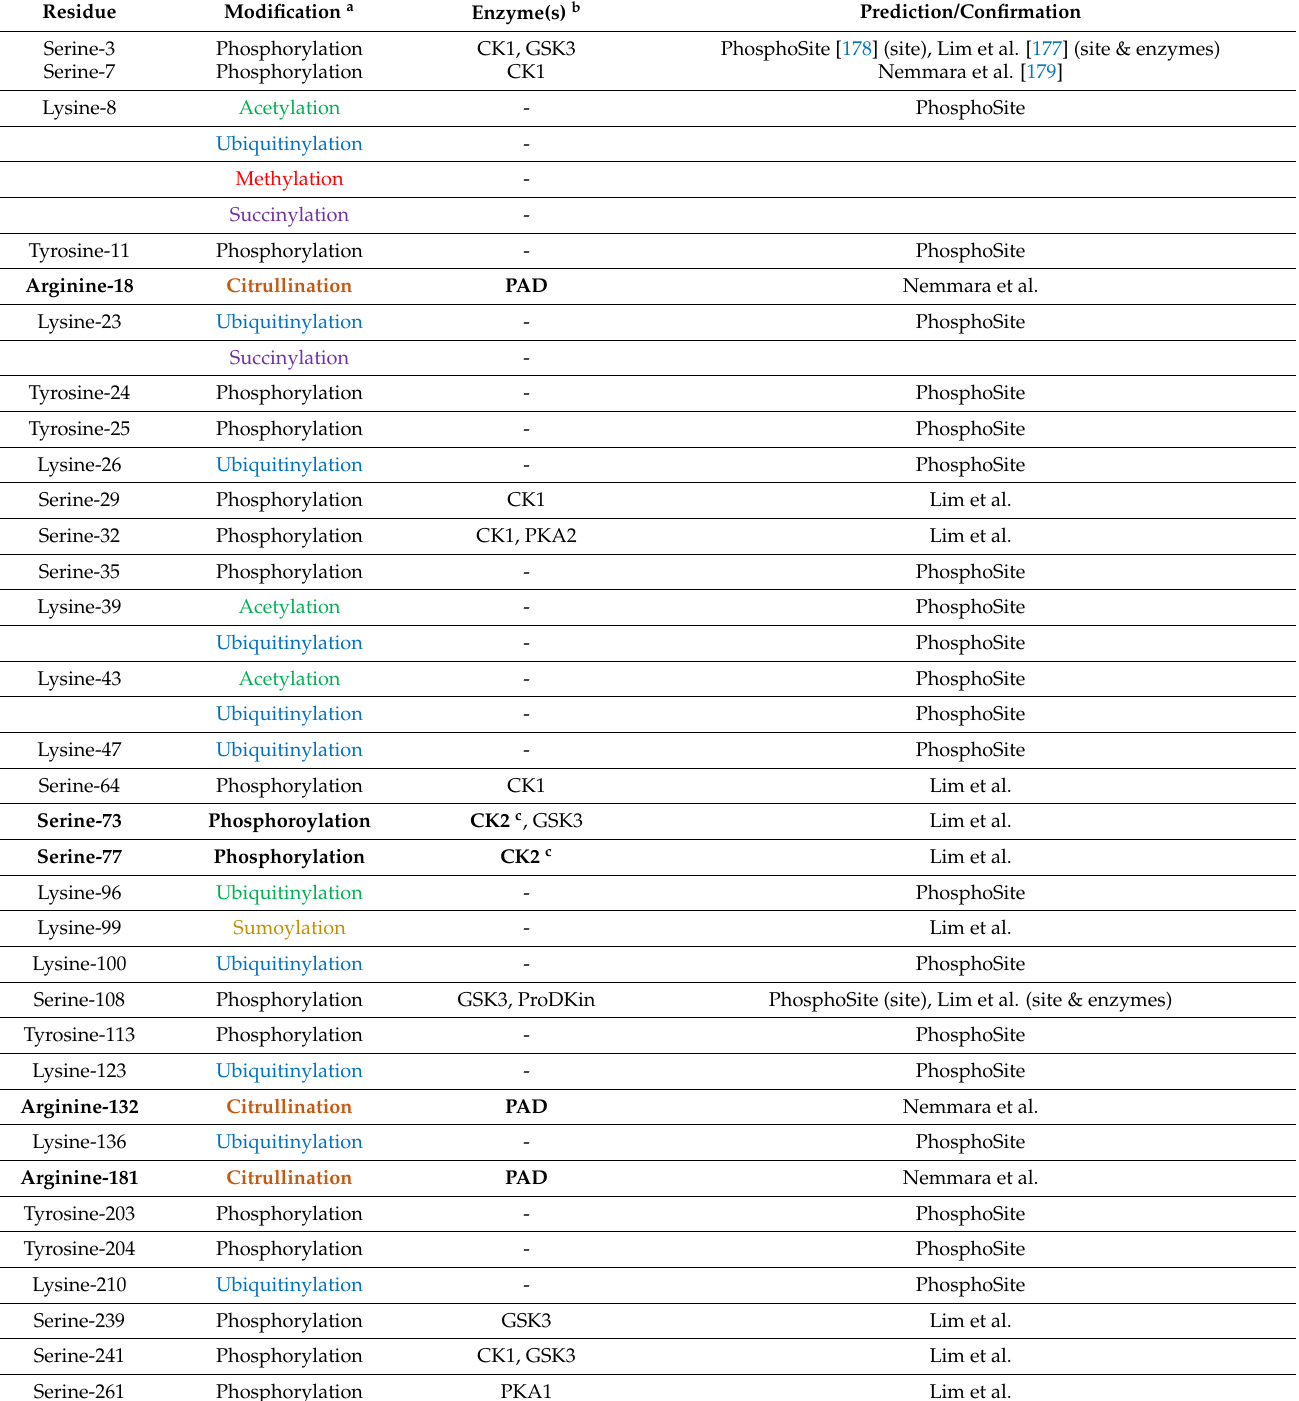
Table 2. Predicted and experimentally demonstrated post-translational modification sites in the NNMT protein sequence.